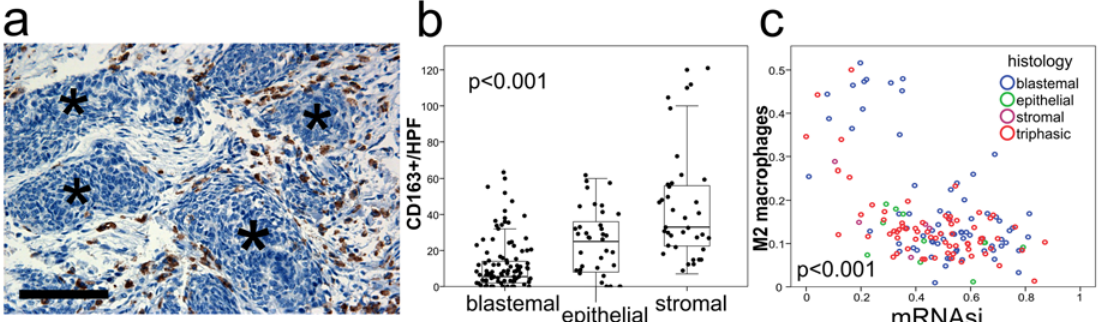
Figure 4. M2 macrophages in WILMS. ( a ) Blastemal tumor areas of WILMS tumors are devoid of M2 macrophages by tumor tissue microarray (TMA) analysis. Representative photomicrograph, CD163 expression by immunohistochemistry in 78 WILMS tumors. Stars (*) indicate blastemal tumor areas (DAB, 400 × ). Scale bar representing 100 µ m. ( b ) Bar graph, low densities of CD163 positive macrophages (immunohistochemistry) in blastemal areas in WILMS tumors compared with epithelial and stromal areas ( p < 0.001, Kruskal–Wallis test). Macrophages were counted in 2–3 HPFs in 1–2 cores per tumor within blastemal ( n = 92), epithelial ( n = 36) and stromal ( n = 36) tumor areas separately. ( c ) Inverse correlation of the relative frequency of M2 macrophages (CIBERSORT) and mRNAsi in WILMS by transcriptomic analysis. (rho= − 0.508, p < 0.001, Spearman rank